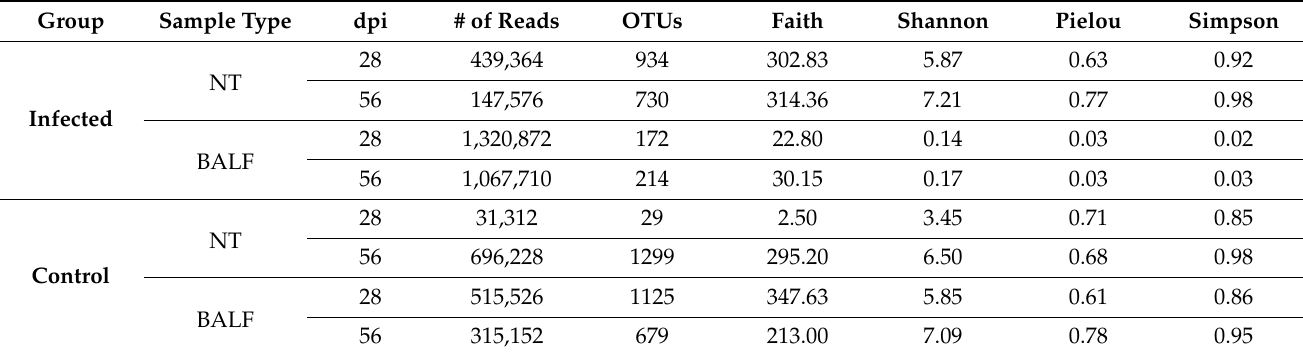
Table 3. Next-generation sequencing (NGS) quality control data, operational taxonomic unit quanti- ties (OTUs) and alpha diversity indexes (Faith, Shannon, Pielou, and Simpson) obtained from pooled nasal turbinate (NT) and bronchus-alveolar lavage fluid (BALF) samples of both infected and control animals at 28 and 56 days-post inoculation